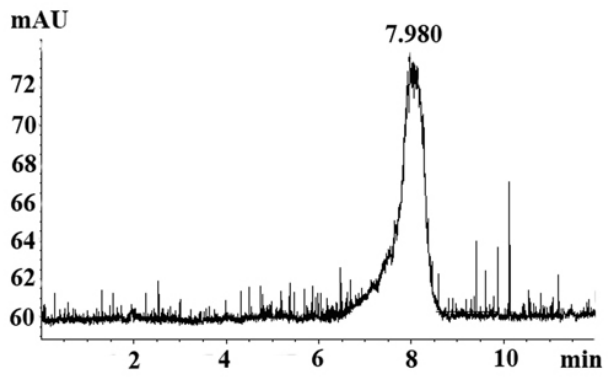
Figure 1. HPLC pro fi le for Gekko sulfated glycopeptides. There was a single and symmetrically sharp peak at 7.98 min in the HPLC pro fi